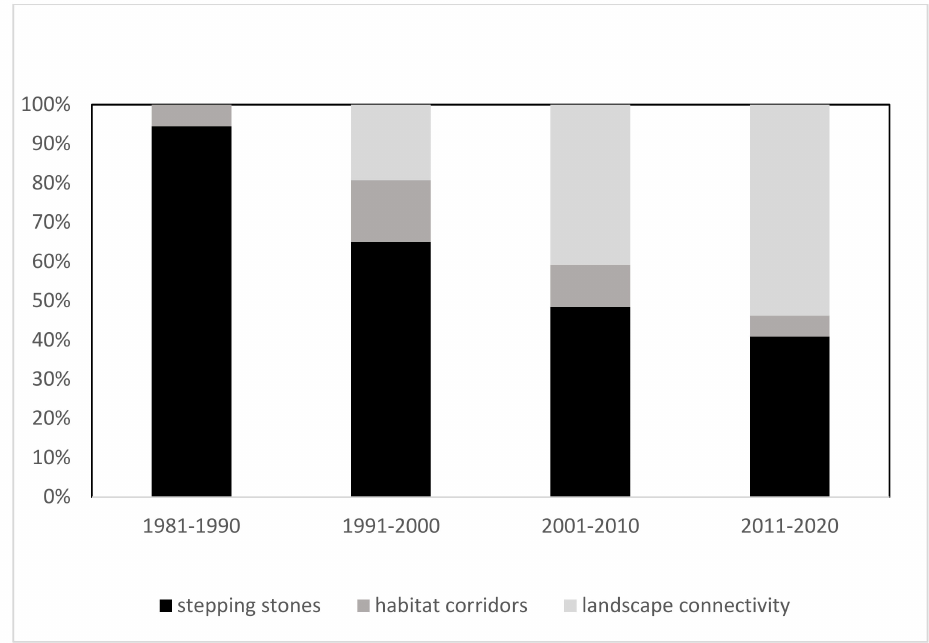
Figure 3. Percentage frequency of recurrence ( y -axis) for the key focal terms from 1981 to